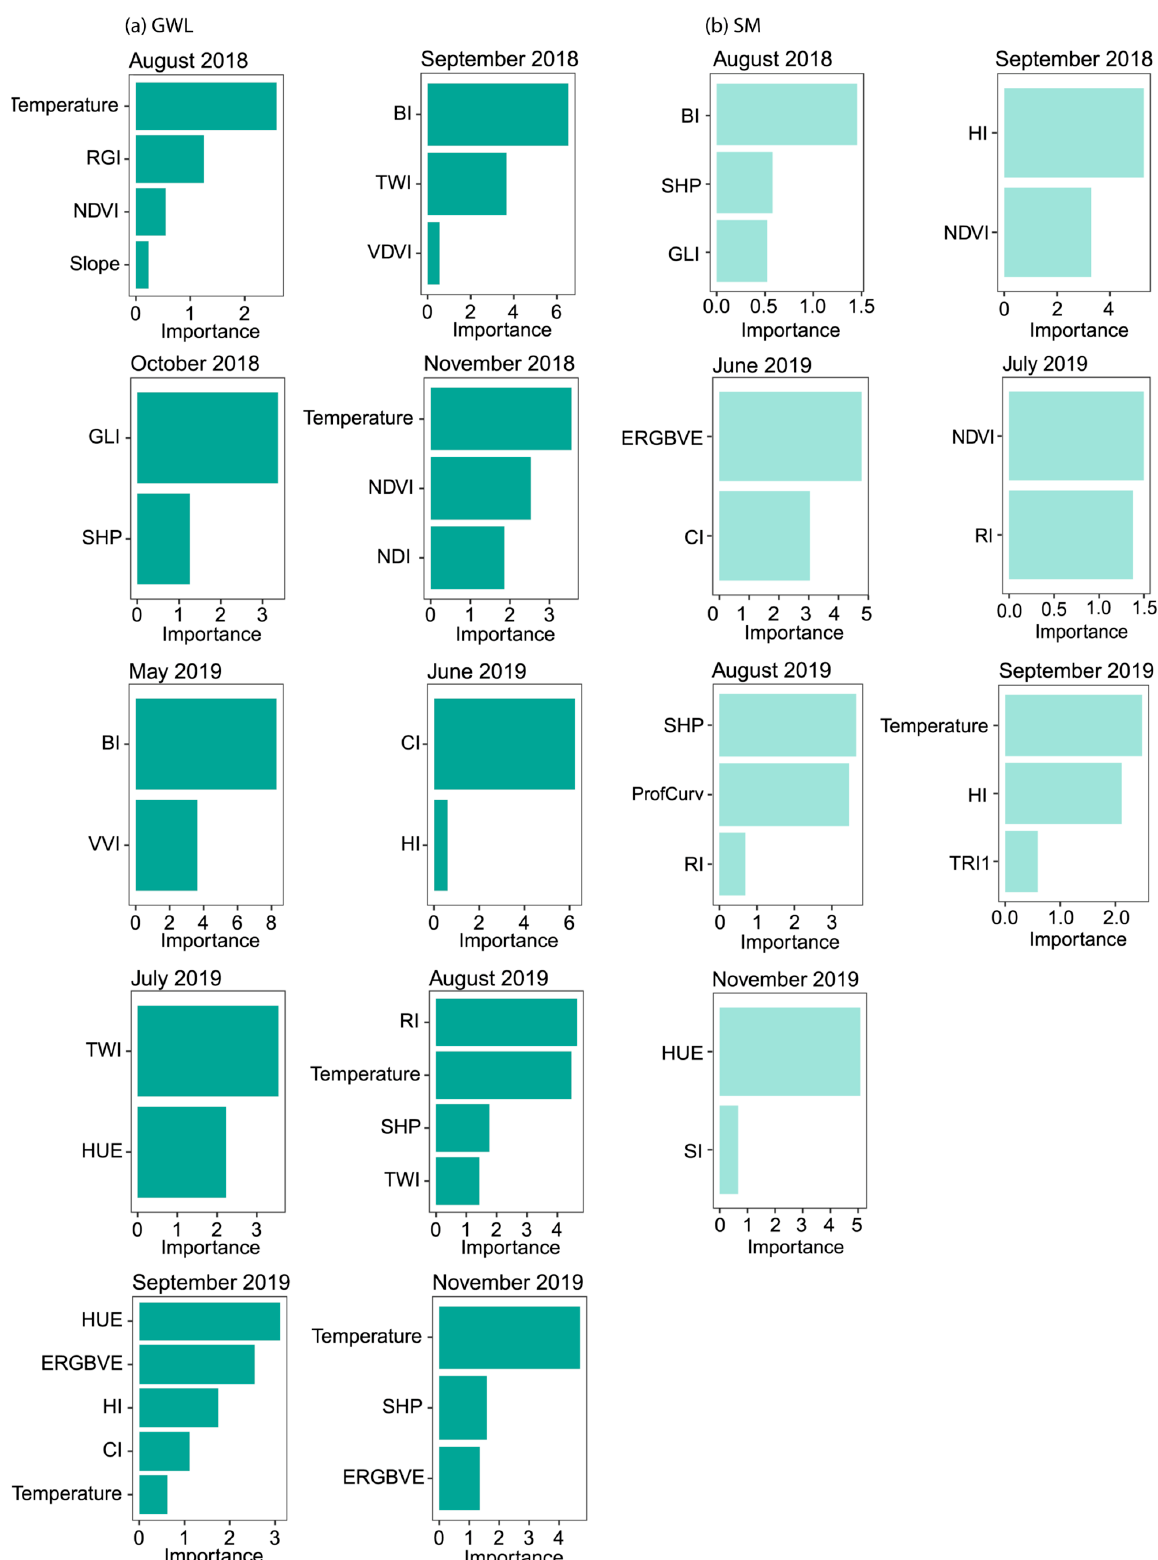
Figure 8. Importance of predictor variables within the Random Forest model based on the forward feature selection (FFS) distributed variables for ( a ) GWL and ( b ) SM at the UP. Importance is shown as the increase of the mean squared error.